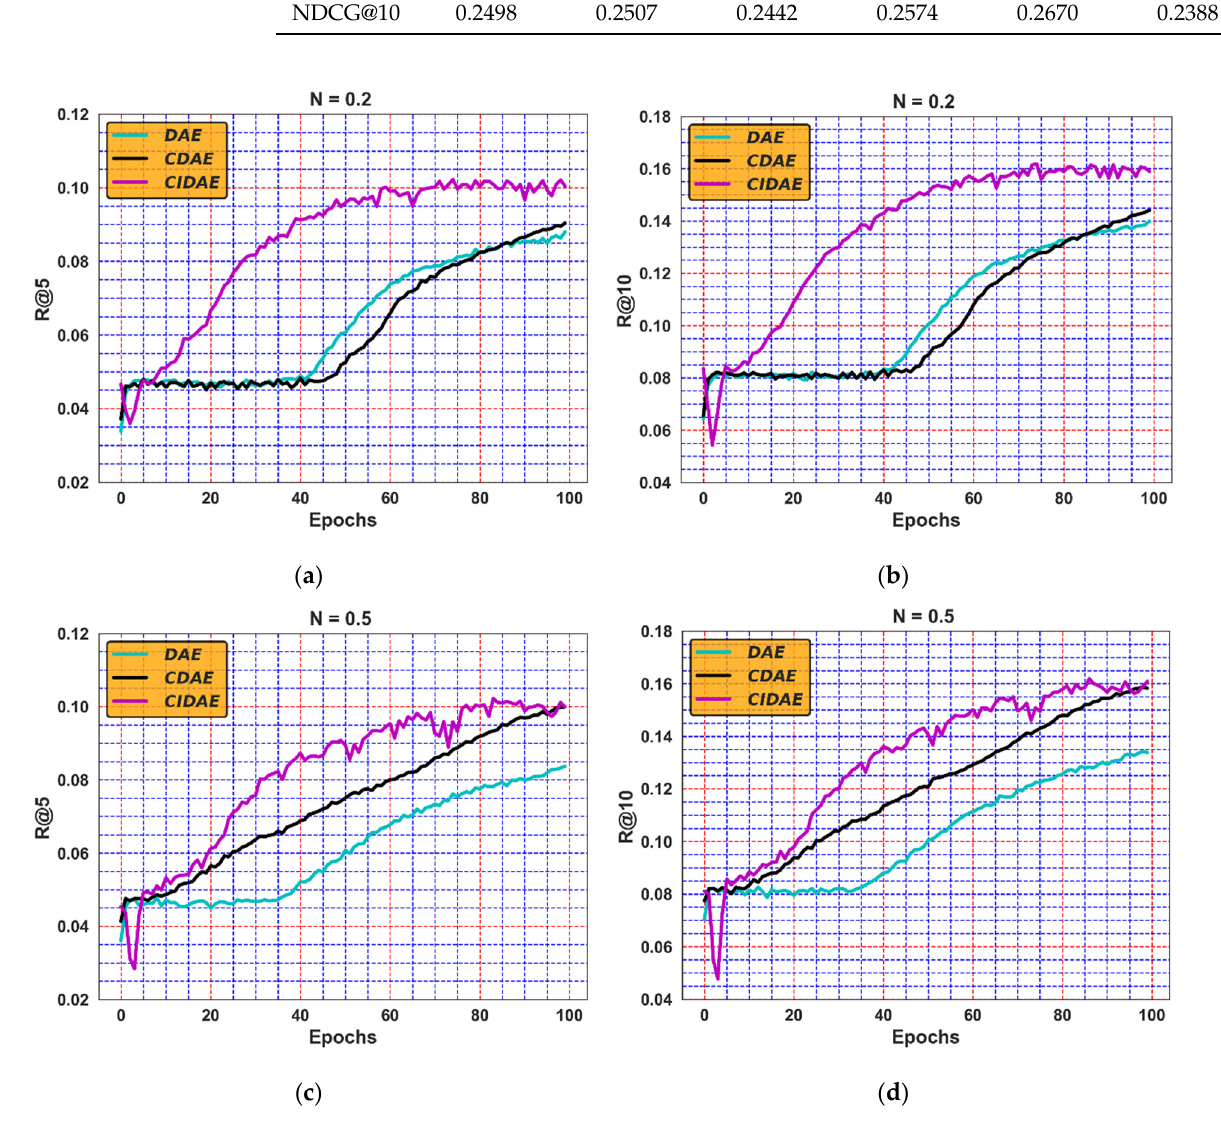
Figure 9. Comparison through R@5, R@10, P@10, NDCG@10, MAP, and NDCG metrics for ML ‐ 100K.